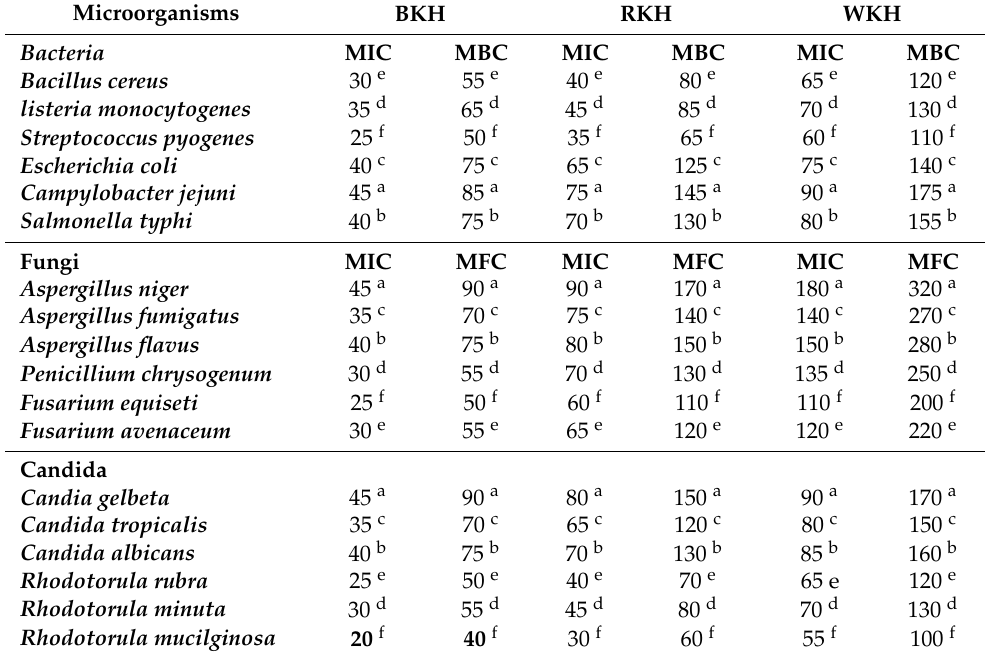
Table 6. Minimum inhibitory concentration (MIC), minimum bactericidal concentration (MBC), and minimum fungicidal concentration (MFC) of black, red and white kidney bean protein hy- drolysate (BKH, RKH and WKH) obtained after 30 min Alcalase hydrolysis at 37 ◦ C, against different microbial